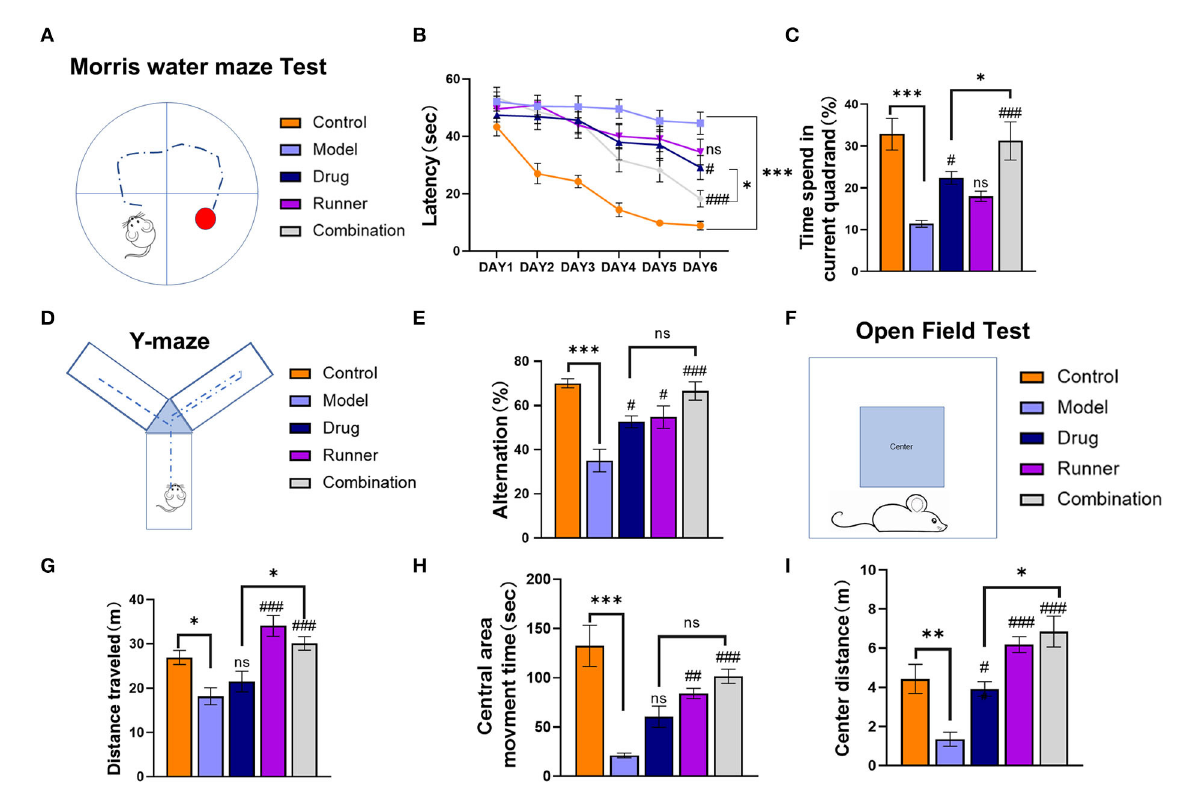
FIGURE3 Cognitive impairment, anxiety, and depression in mice of each group. (A) Schematic of the Morris water maze task. (B,C) The 6-day latency of each group and time spent in the current quadrant on day 6. (D) Schematic of the Y-maze test task. (E) The spontaneous alternation in behavior of each group. (F–I) The open-field test was performed to record the total distance traveled throughout the open-field arena, entries into the center zone, duration spent within the center zone, and distance traveled within the center zone. Data were shown as mean ± SEM. ns > 0.05, * P < 0.05, ** P < 0.01, *** P < 0.001; # P < 0.05, ## P < 0.01, ### P < 0.001, comparison of the model group with each treated group (B: three-way ANOVA or two-way ANOVA was used for the rest of the